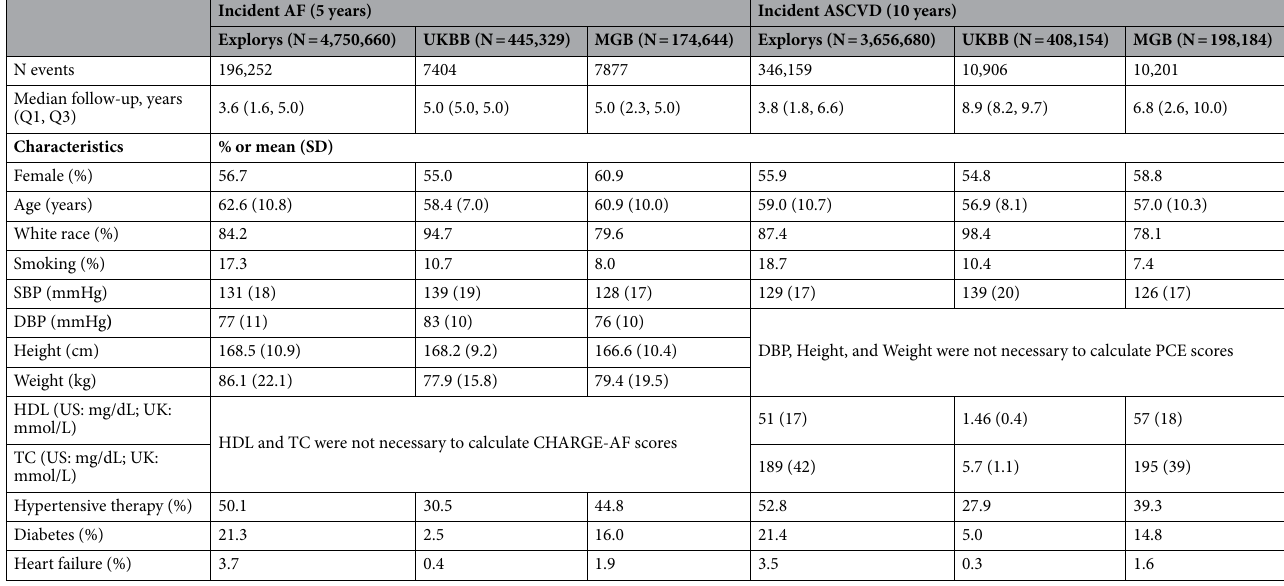
Table 1. Baseline